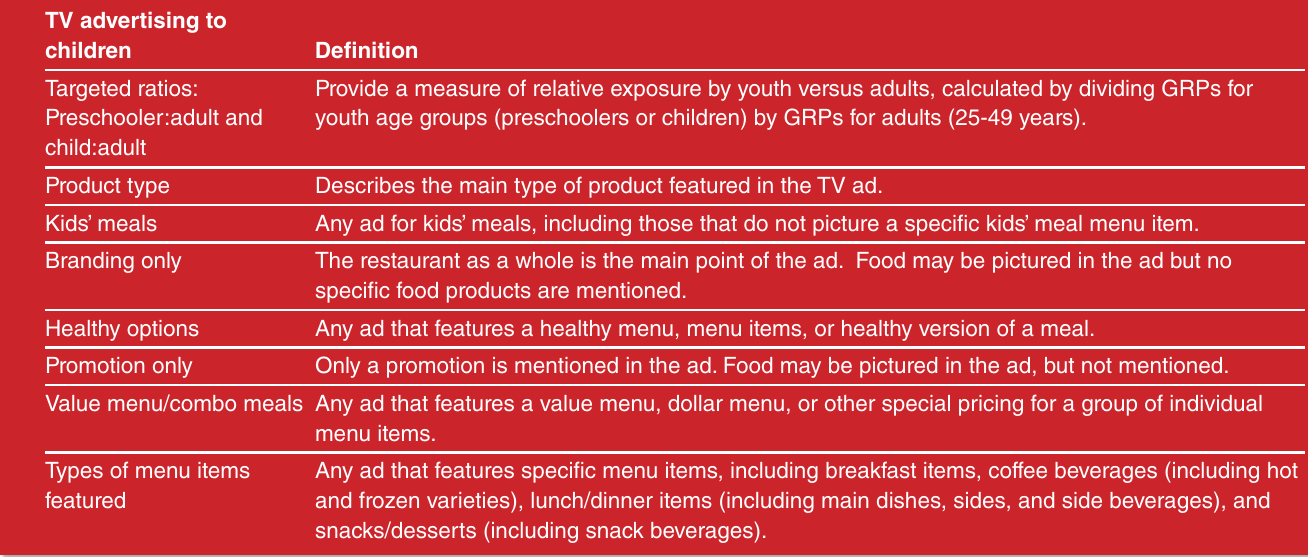
Ranking Table 6 provides child:adult targeted ratios for the top-25 advertisers. In 2012, preschoolers and children viewed one-half the number of fast food ads that adults viewed in total. McDonald’s was the only restaurant that advertised more to children than adults. Children (6-11 years) viewed 8% more ads for McDonald’s than adults viewed, and preschoolers viewed just 9% fewer than adults. Domino’s and Burger King had the next highest child:adult targeted ratios at .64 and .59 respectively. The average preschooler:adult targeted ratio was .47 and the average child:adult targeted ratio was .54.